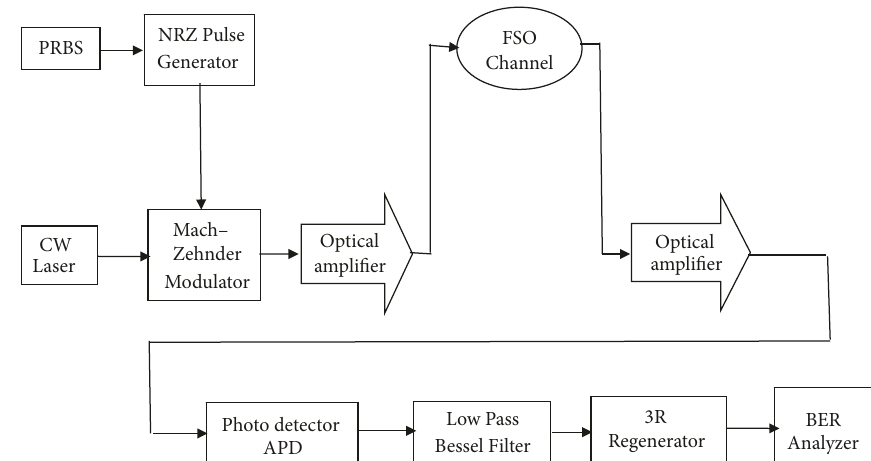
Figure 2: Simulation layout of (1T X /1R X ) FSO system.